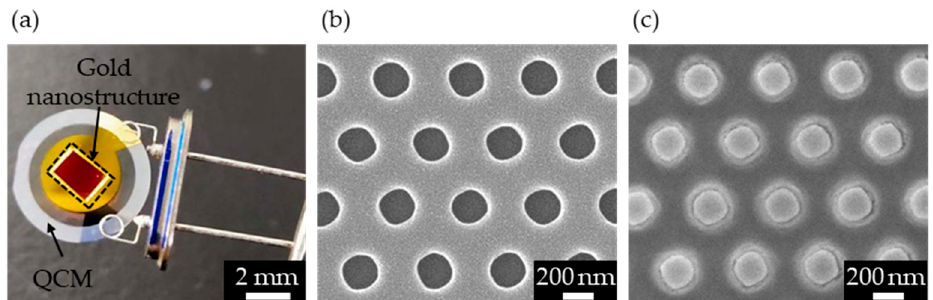
Figure 2. ( a ) Image of the fabricated QCM device with gold nanostructures. ( b ) SEM image of the COP mold (hole). ( c ) SEM image of the gold nanostructure (pillar).